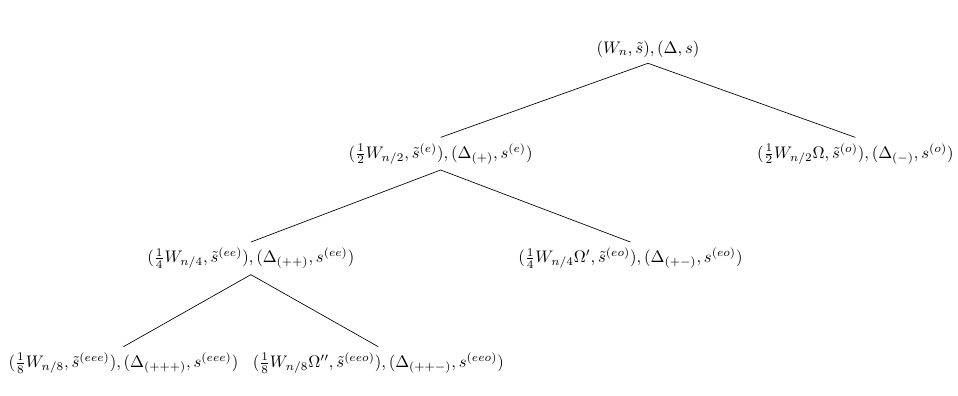
Figure 1: Recursive folding/dimension